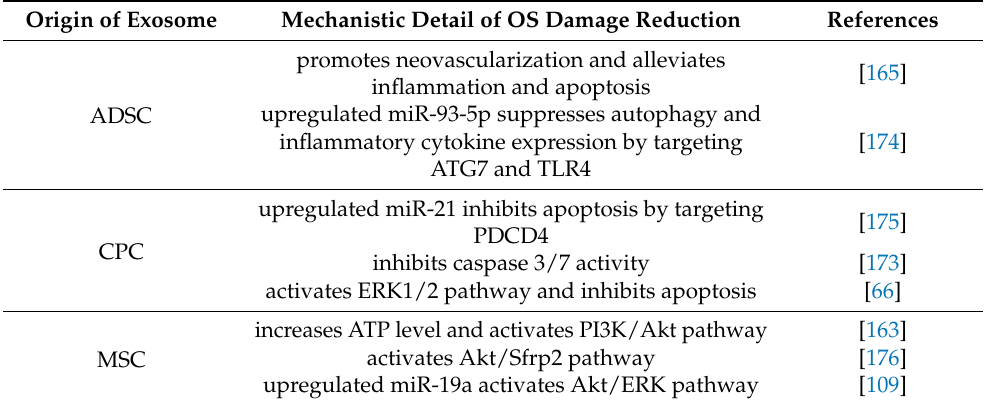
Table 1. Effect of exosomes derived from stem cells on the reduction of myocardial oxidative stress (OS) damage. ADSC: adipose-derived stem cell; CPC: cardiac progenitor cell; MSC: mesenchymal stem cell; ATG7: autophagy-related 7; TLR4: Toll-like receptor 4; PDCD4: programmed cell death 4. Origin of Exosome Mechanistic Detail of OS Damage